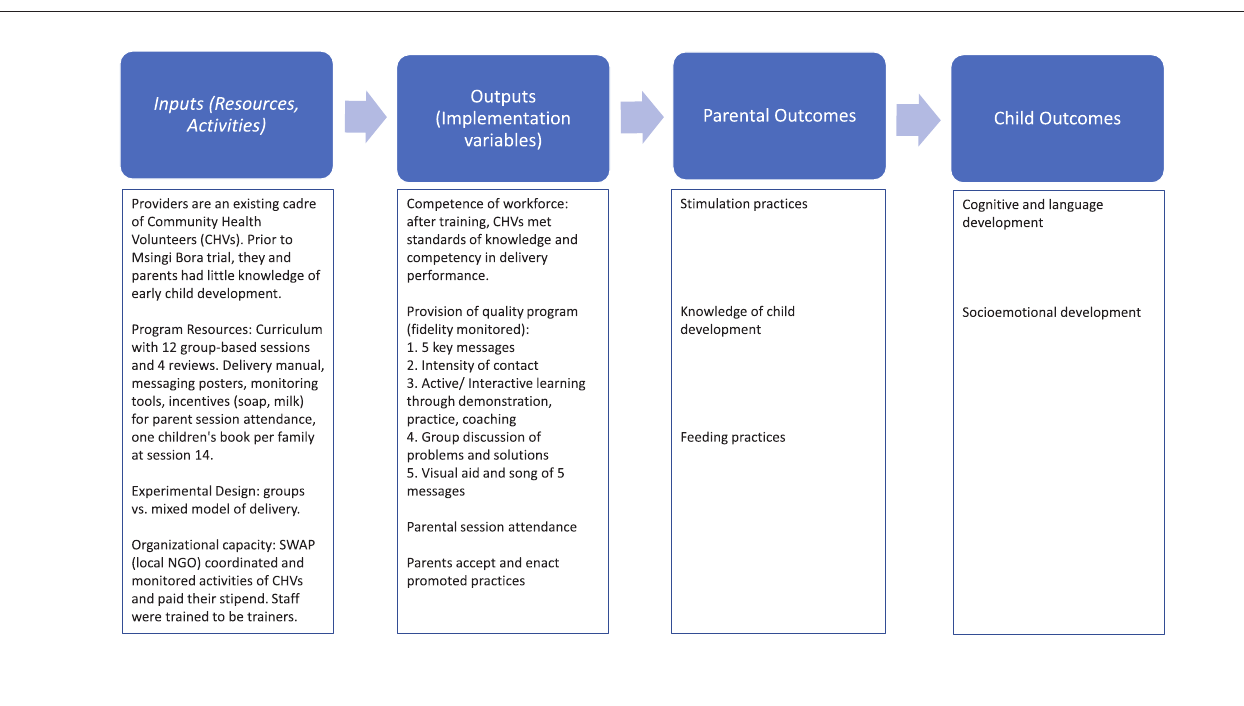
Frontiers in Public Health |